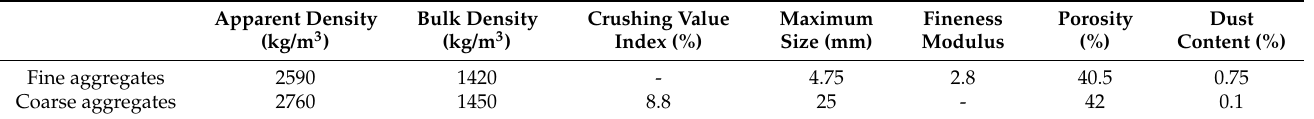
Table 4. Physical characteristics of aggregates.